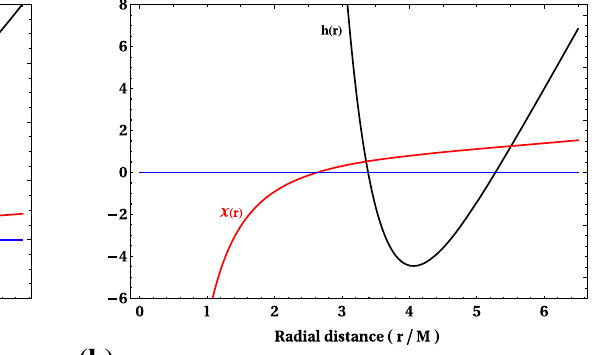
covered by the event horizon so that physically accessible regionboundedbyeventandcosmologicalhorizonsisbenign and